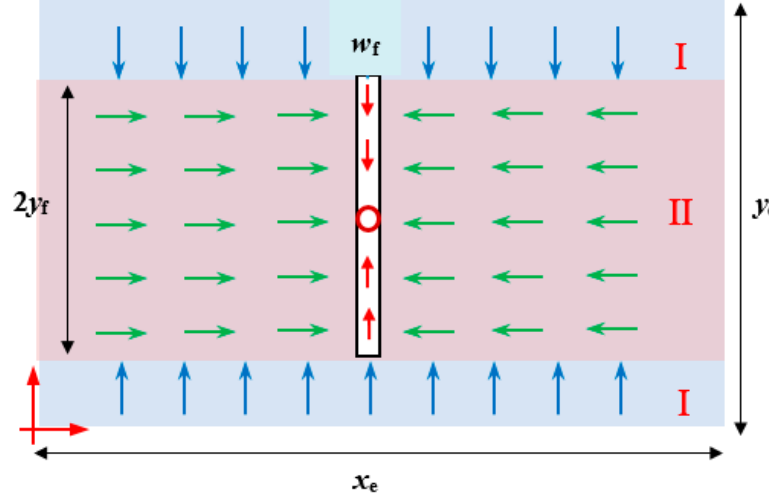
Figure 4. Diagram of composite flow model for vertically fractured well.